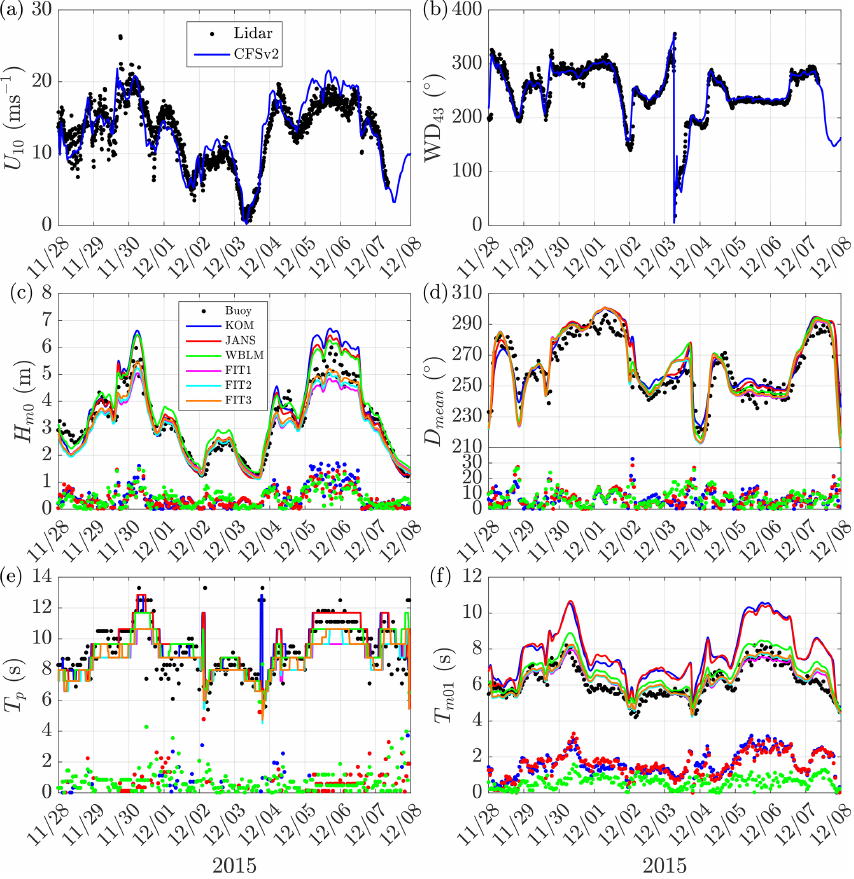
Figure 6. Time series during two winter storms in the RUNE project. (a) The 10m wind speed from CFSv2 and measurements calculated from a logarithm wind profile from lidar measurements at 43, 50, 62, 82, and 100m. (b) Wind direction from CFSv2 and lidar measurement at 43m. (c) Modeled significant wave height (solid lines) in comparison to buoy measurements (black dots); colored dots show the absolute error. (d) Mean wave direction. (e) Peak wave period. (f) Mean wave period.